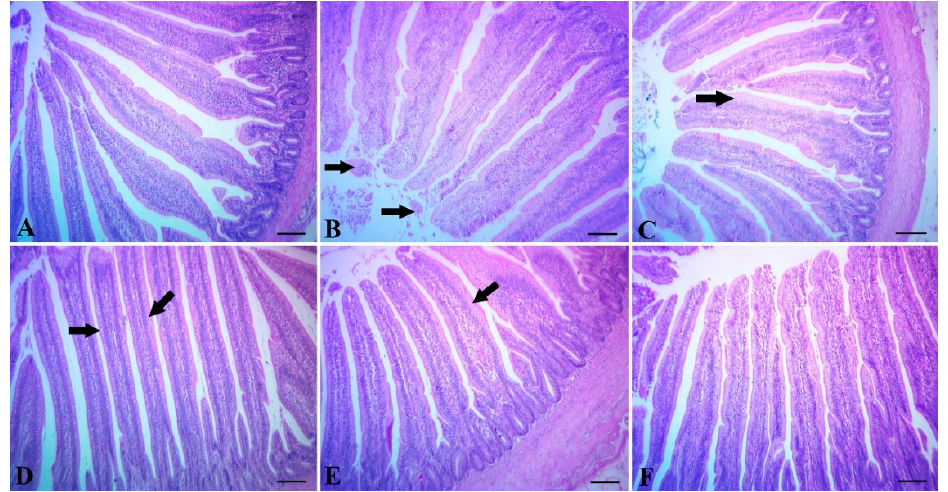
Figure 2. (A) Intestine of the control group without Clostridium challenge, showing normal tissue architecture. (B) The intestine of chicks supplemented with Maxus showing mild desquamation of villous epithelium (arrow). (C) The intestine of chicks supplemented with Clostat, the columnar epithelium lining the villi into goblet cells (arrow). (D) The intestine of chicks supplemented with Sangrovit, showing moderate metaplasia of the columnar epithelium lining the villi into goblet cells (arrow). (E) The intestine of chicks supplemented with Clostat + Sangrovit, showing mostly normal villi, except for mild metaplasia of the columnar epithelium lining the villi into goblet cells (arrow). (F) The intestine of chicks supplemented with Gallipro, showing normal tissue architecture with normal intestinal villi. Scale bar = 100 µm.